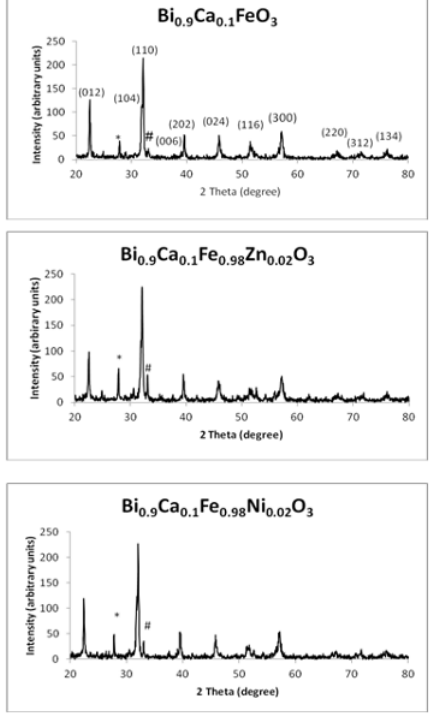
Figure 1: The XRD of the Ca-doped